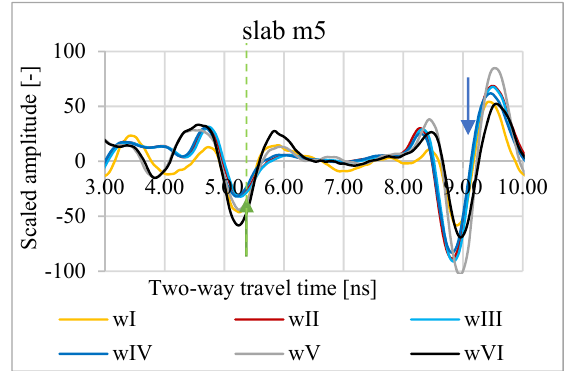
Figure 4. A-scans of m3 ( a ) and m4 ( b ) slabs in atmospheric conditions wI, wII, wIII, wIV, wV, and wVI; green arrow—assumed zero level, blue arrow—assumed bottom of the slab.